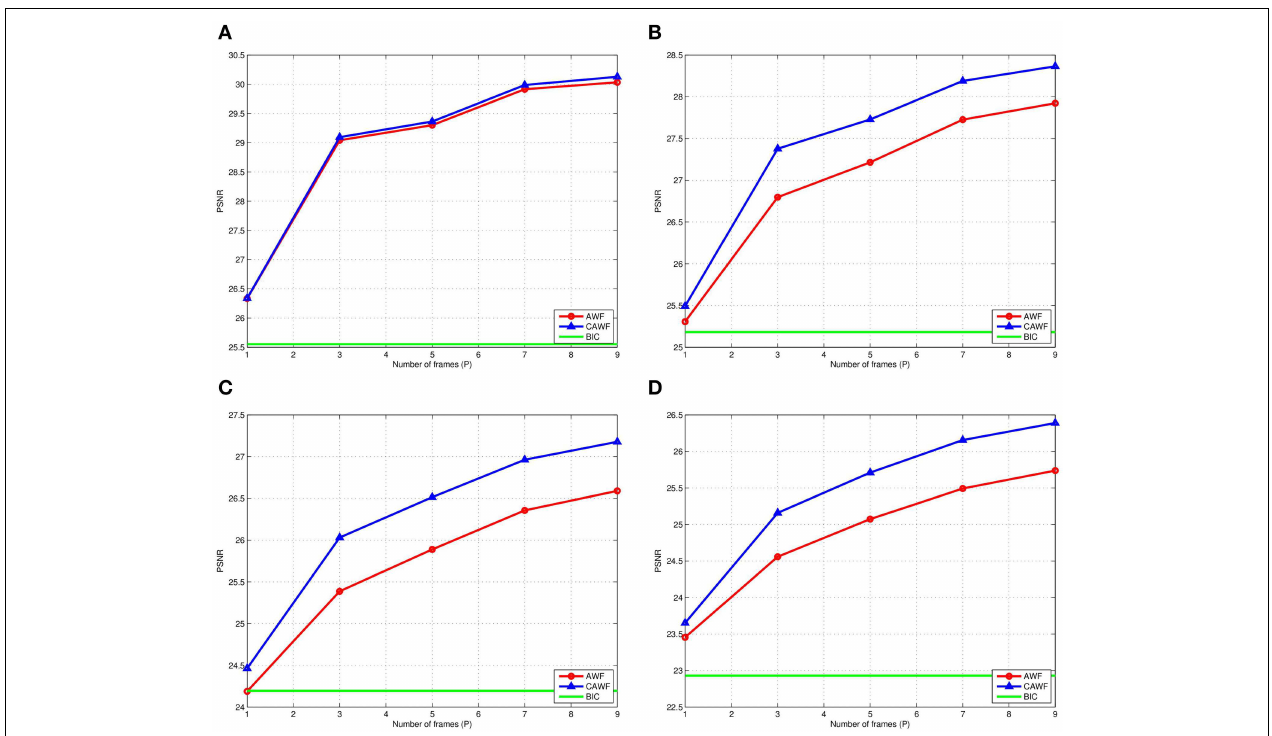
1 , (B) σ η 5 , (C) σ η 10 , and (D) σ η 15 . These = = = =